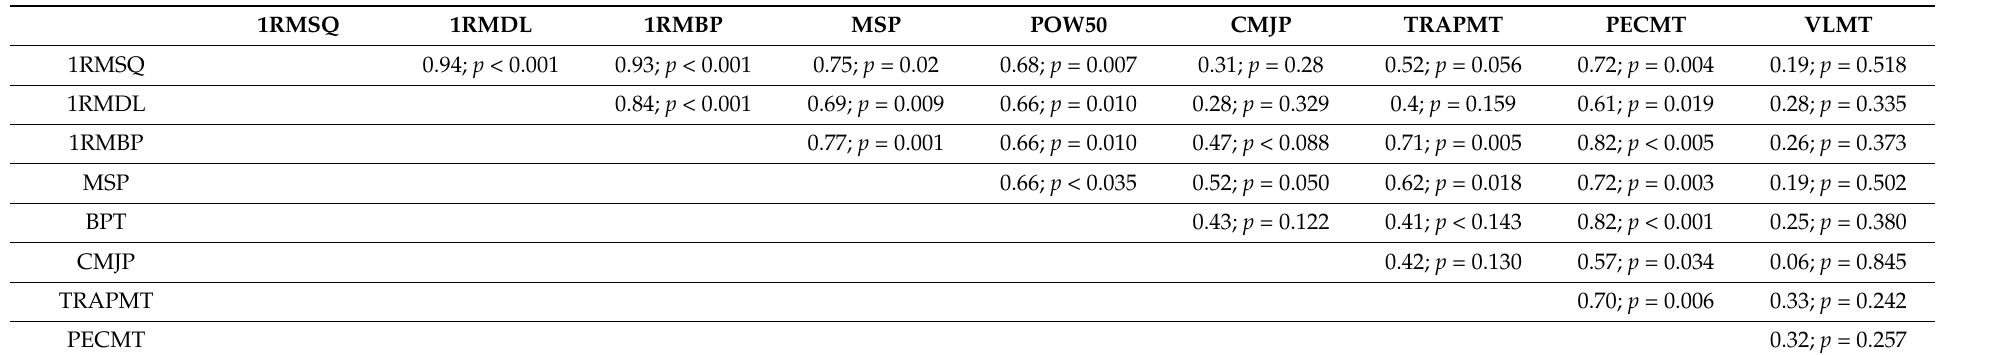
Table 4. Correlations between the different parameters of performance and muscle morphology in female group. 1RMSQ = 1RM squat; DL = deadlift; BP = bench press; MSP = mid-shin pull; BPT = bench press throw; CMJP = countermovement jump power; TRAPMT = muscle thickness of trapezius muscle; PECMT = muscle thickness of pectoral muscle; VLMT = muscle thickness of vastus